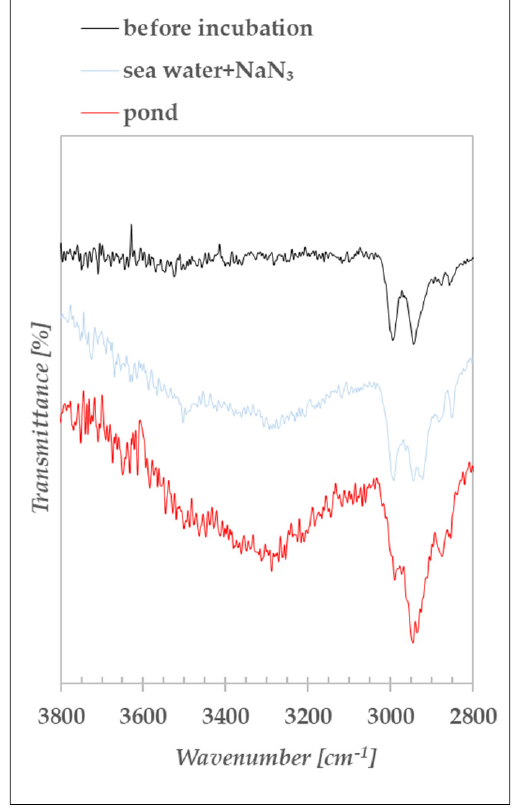
Figure 4. ATR-FTIR spectra of the PLA sample before degradation and after 12 months incubation in pond and seawater with NaN 3 as the wavenumber of 2800–3800 cm − 1 . Source: Own research.